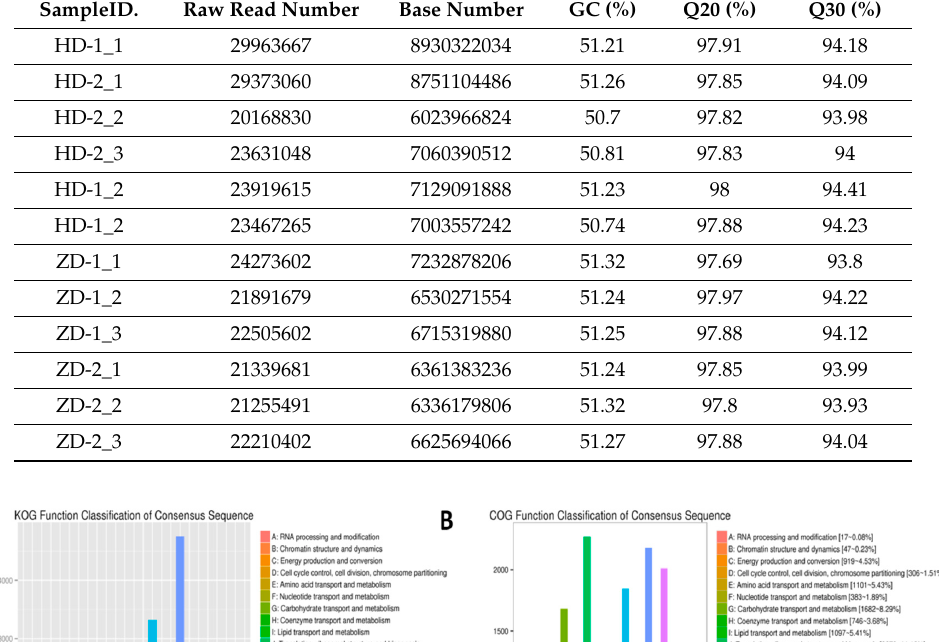
Table 2. Overview of the transcriptome sequencing dataset and quality check.